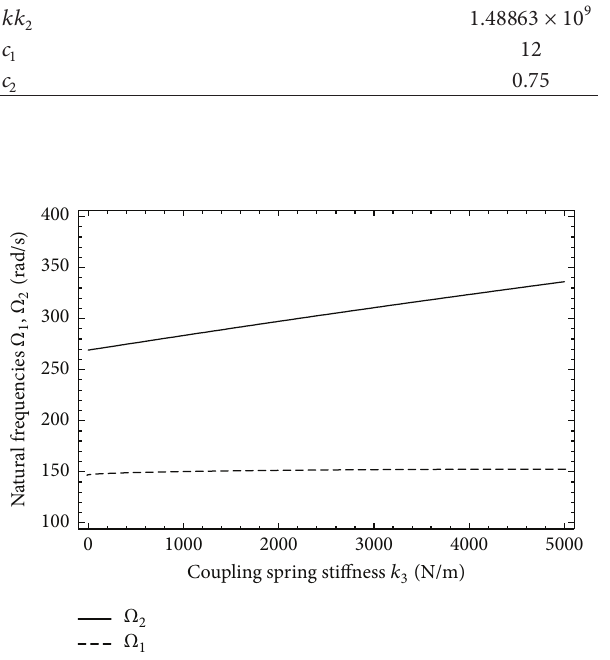
Figure 2: The natural frequencies of the structure without time delay.